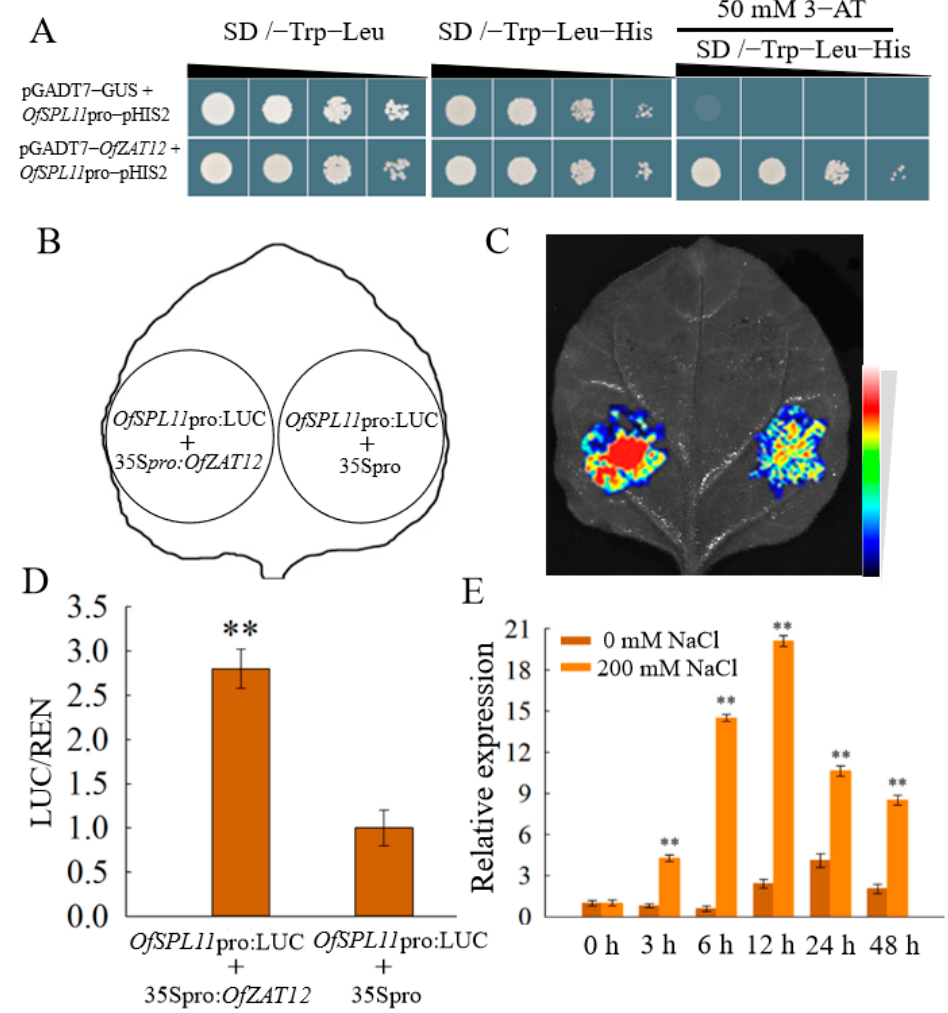
Figure 9. OfZAT12 regulated the expression of OfSPL11. ( A ) Yeast one-hybrid assay to verify the interaction between OfZAT12 and OfSPL11 ; ( B – D ) the Dual-Luciferase Assay Reagents were used to measure the activities of firefly LUC and REN; ( E ) OfSPL11 expression levels in Osmanthus fragrans young leaves after 200 mM NaCl treatment. The internal reference gene for O. fragrans is OfACT , and three biological re-reads were performed for each reaction. ** p < 0.01 were used to determine statistical significance.